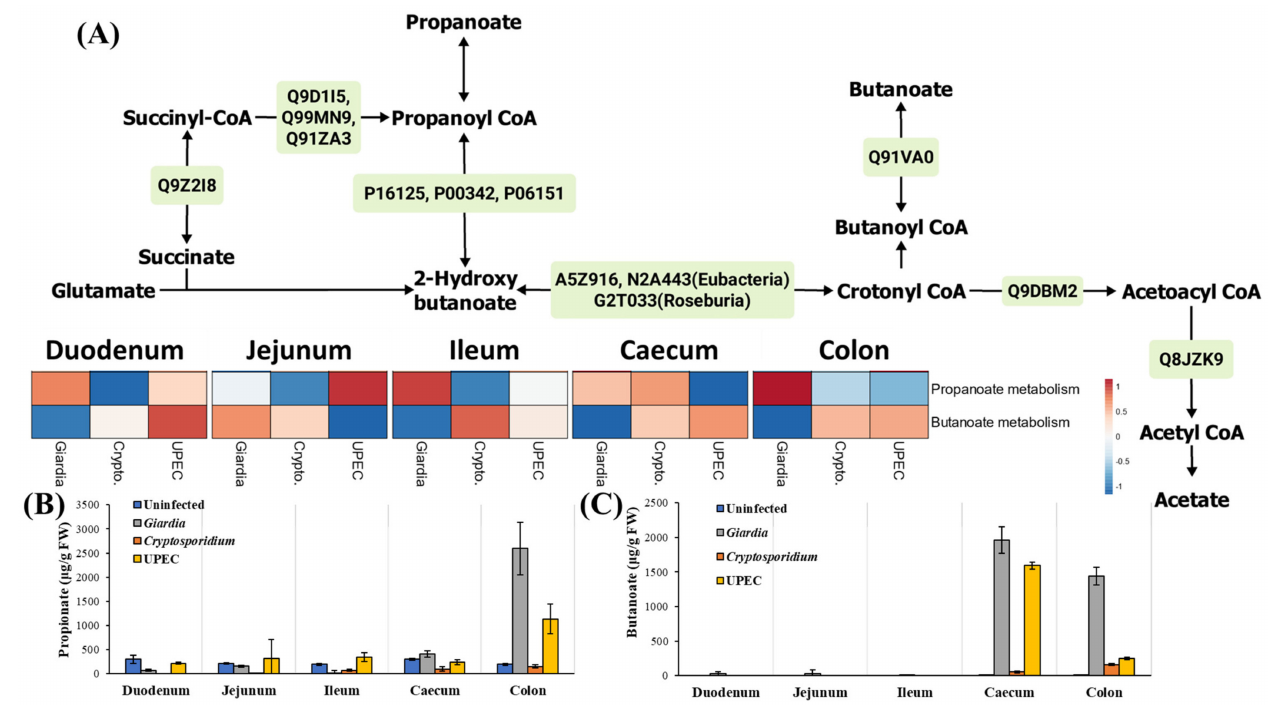
Figure 6. The ( A ) major proteins (green boxes) and metabolites contributing to fatty acid metabolism in mouse gut during giardiasis. The heatmap represents relative upregulation (red) and downregula- tion (blue) of individual pathways in the mice with infected gut with respect to the uninfected mice. Note: The protein identifiers refer to the Uniprot IDs. ( B ) Propanoate and ( C ) butanoate expression in